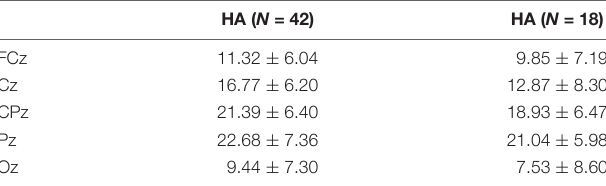
TABLE 4 | P300 amplitude of each group in 2-back task ( µ V, mean ± standard deviation).